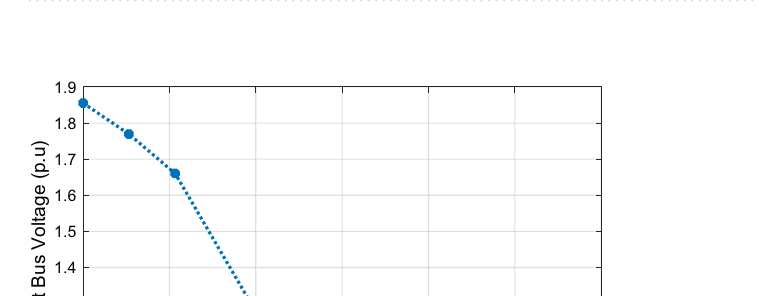
Table 2. Bus Ranking of Nigerian 330 kV power grid: comparison of P–V and Q–V-based indices.